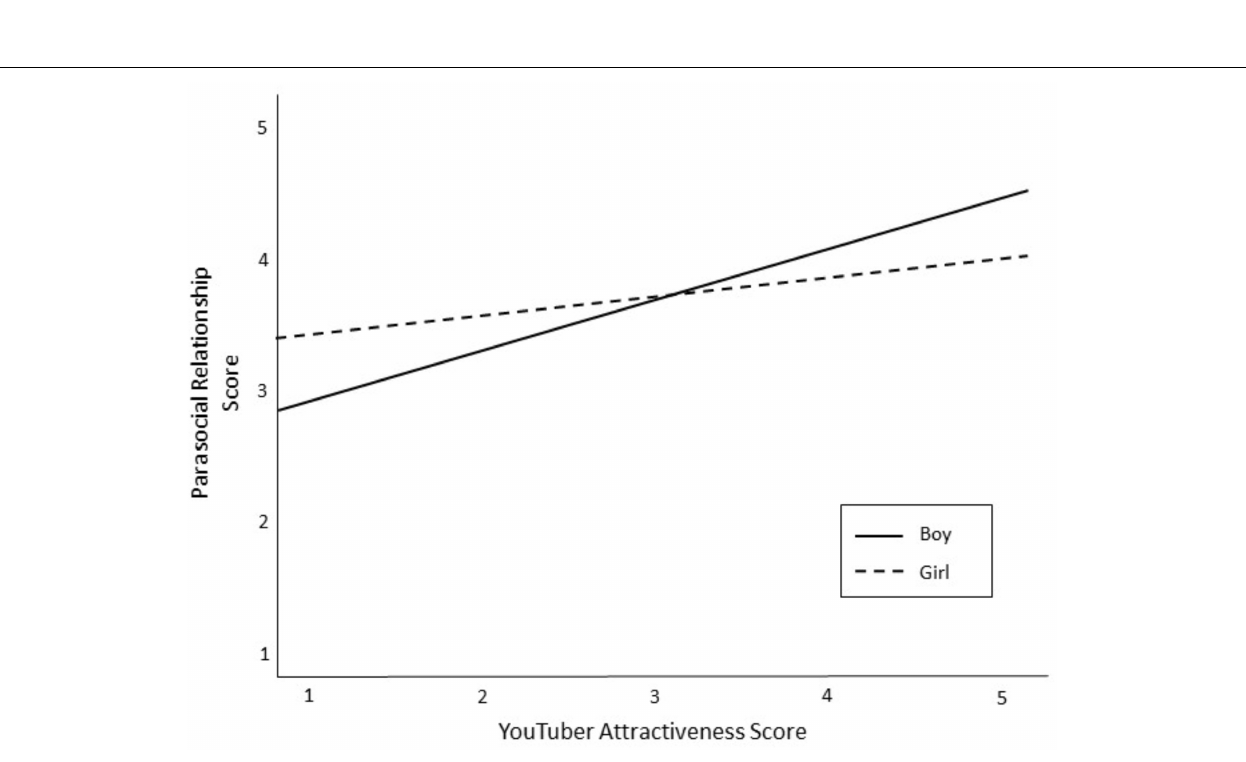
FIGURE 2 | The relationship between YouTuber successfulness and PSR as moderated by gender of child.